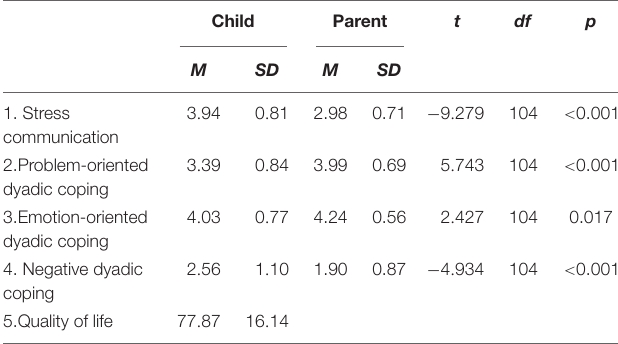
TABLE 1 | Means and standard deviations of main study variables in the overall